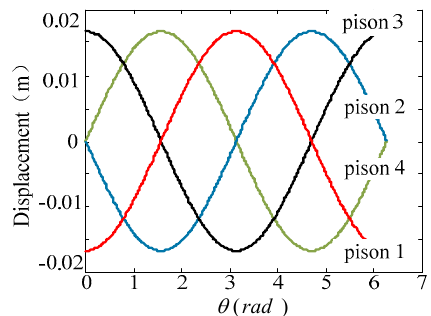
Figure 8. The displacements of different piston rods.